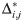
Visual representation of the CoDiNA method for a 3-network comparison: Scores definition.The strength score (Δi,j*) and the internal score (Δρ˜i,j) are shown in panels 3a and 3b, respectively. The Δi,j* score is calculated as the Euclidean distance from the center of the cube to the set of links. This score allows the selection of strong links. Links that have a big variation in their weight have lower scores, while links with higher similarities have higher scores. The second score, Δρ˜i,j, is the distance from the link weight to the categorical weight (ρ˜i,j) and allows the selection of links that were well-classified in the Φ category. Links with a low Δρ˜i,j score are not assigned to a particular Φ category, while well-classified links receive higher Δρ˜i,j scores. Both scores can be combined to visualize the filtered network that contains only strong and well-classified links, as shown in 3c. Finally, the CoDiNA network with classified links and nodes is displayed in panel 3d.